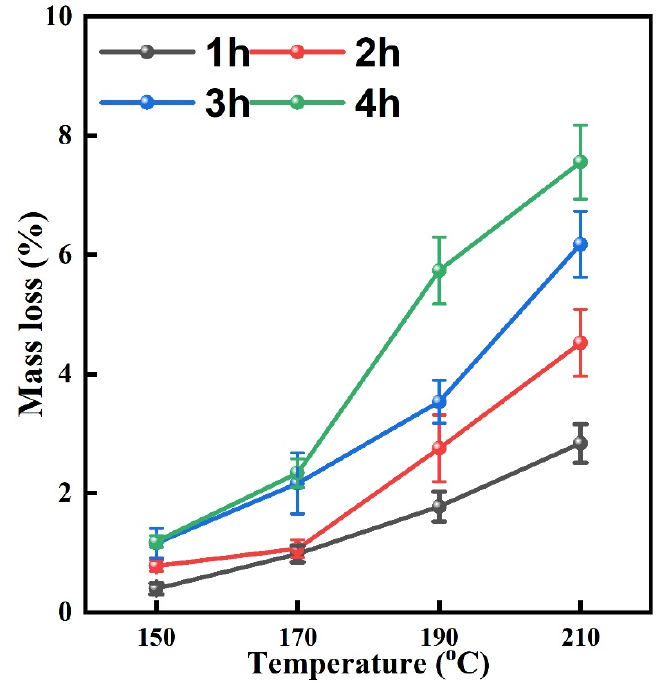
Figure 5. The mass loss of heat-treated bamboo samples.